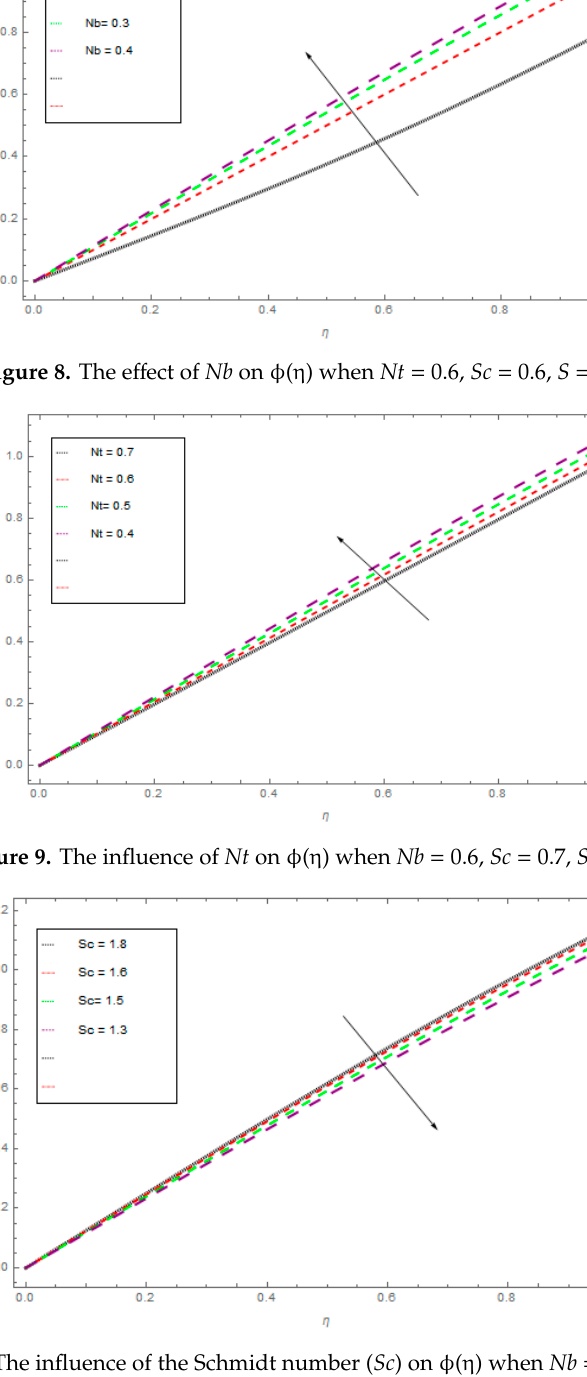
Figure 10. The influence of the Schmidt number ( Sc) on ϕ ( η ) when Nb = 0.6, Nt = 0.5.